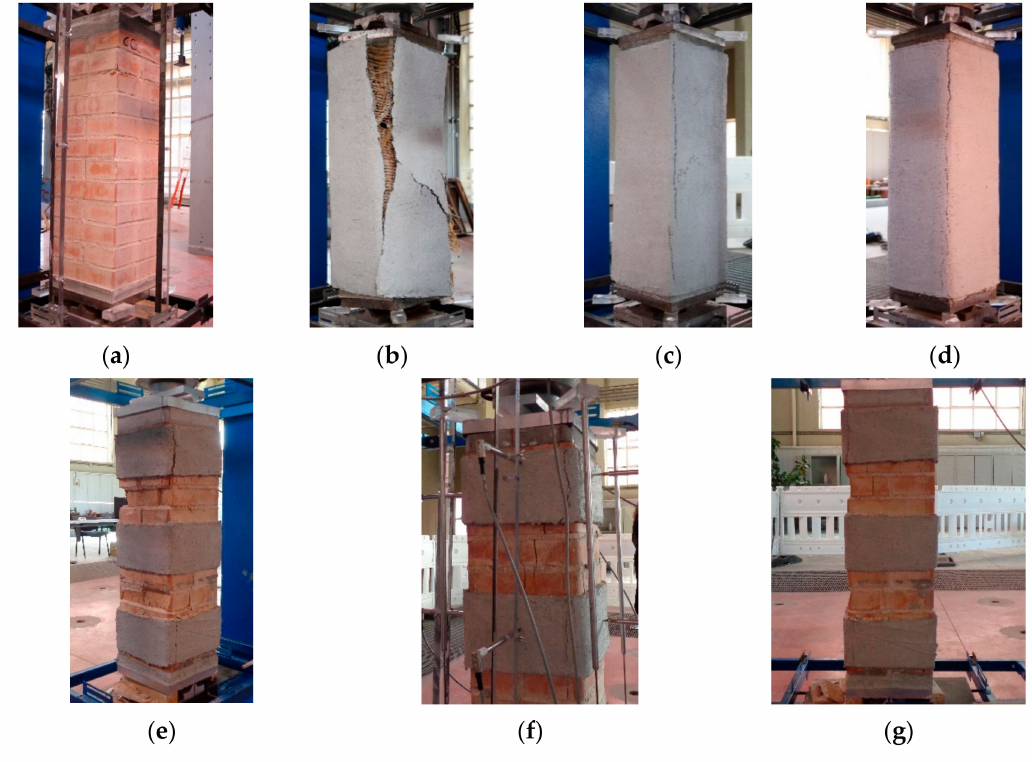
Figure 6. Failure configurations of confined columns: ( a ) un-confined column, ( b )